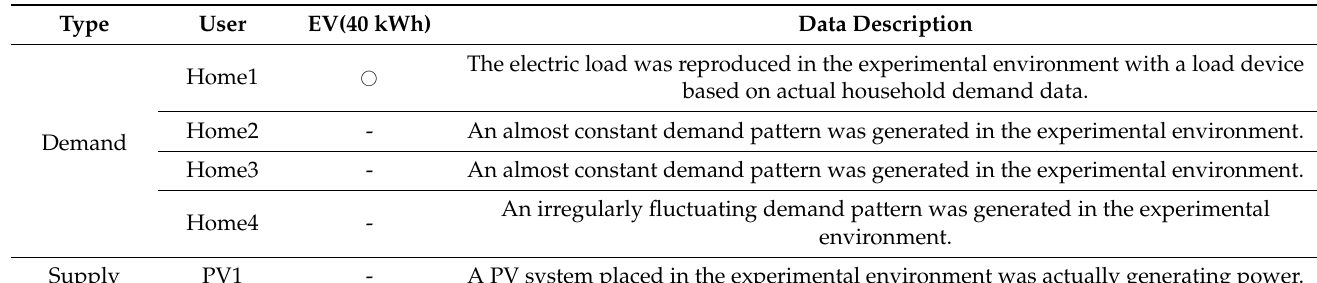
Table 2. Composition of consumers and generators in the demonstration experiment.